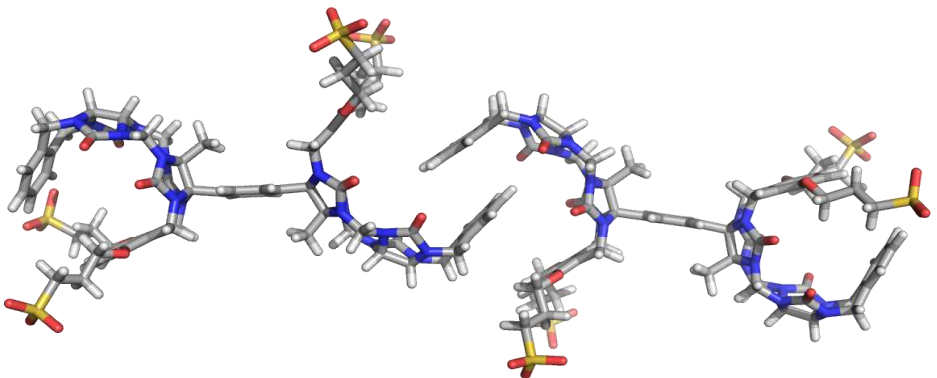
(Figure 1). As one molecule of clip 4 possesses two sites capable to self-associate, clip 4 is a promising building block for supramolecular polymers in aqueous solution.